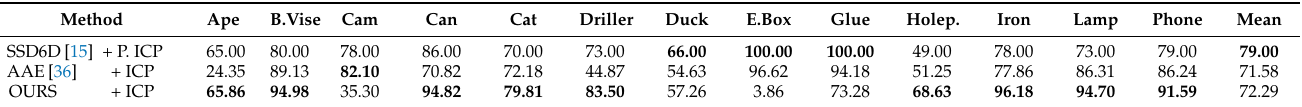
Table 3. Results on LINEMOD dataset using the ADD metric with a threshold of 10%, when depth information is used for pose refinement. Higher is better.